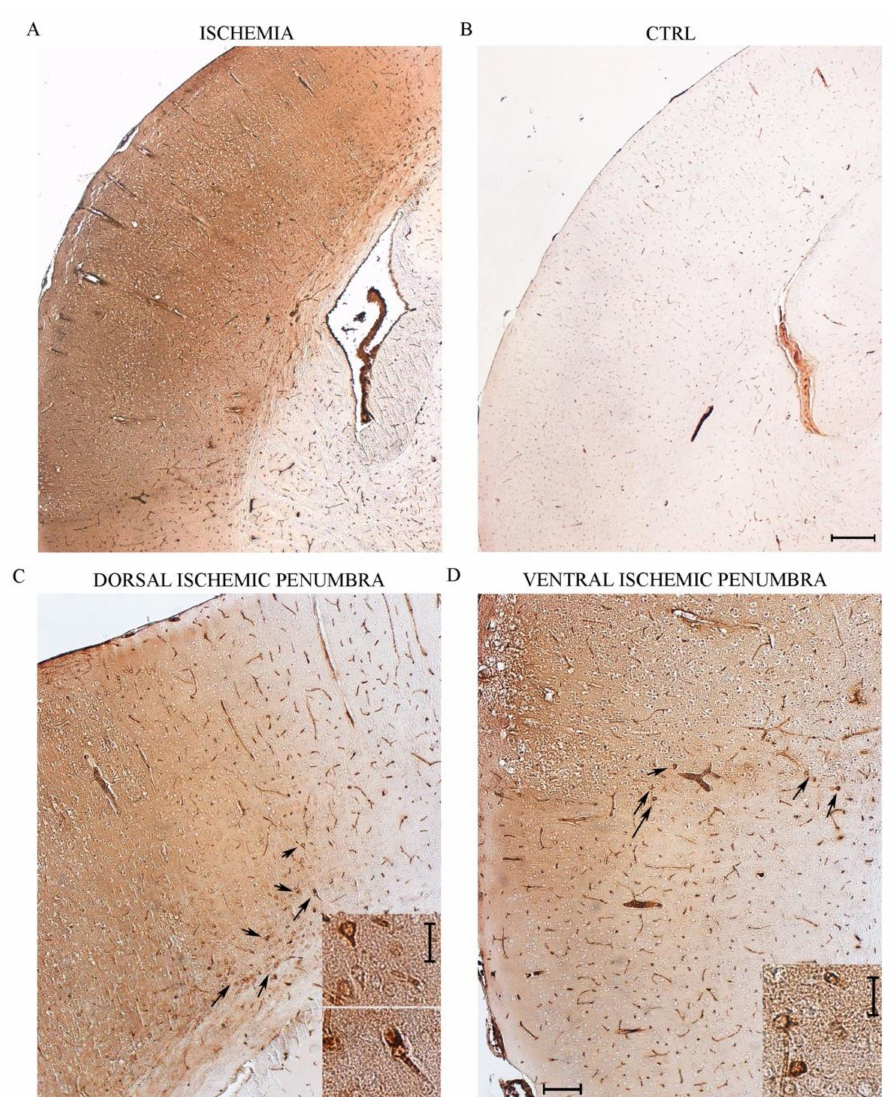
Figure 3. Representative HSP70-immuno-staining in the area penumbra. This picture shows Heat Shock Protein70 positive neurons in the area penumbra of ischemic ( A ) vs. control mice ( B ). In ( C , D ) representative pictures shows a higher magnification of dorsal and ventral ischemic area